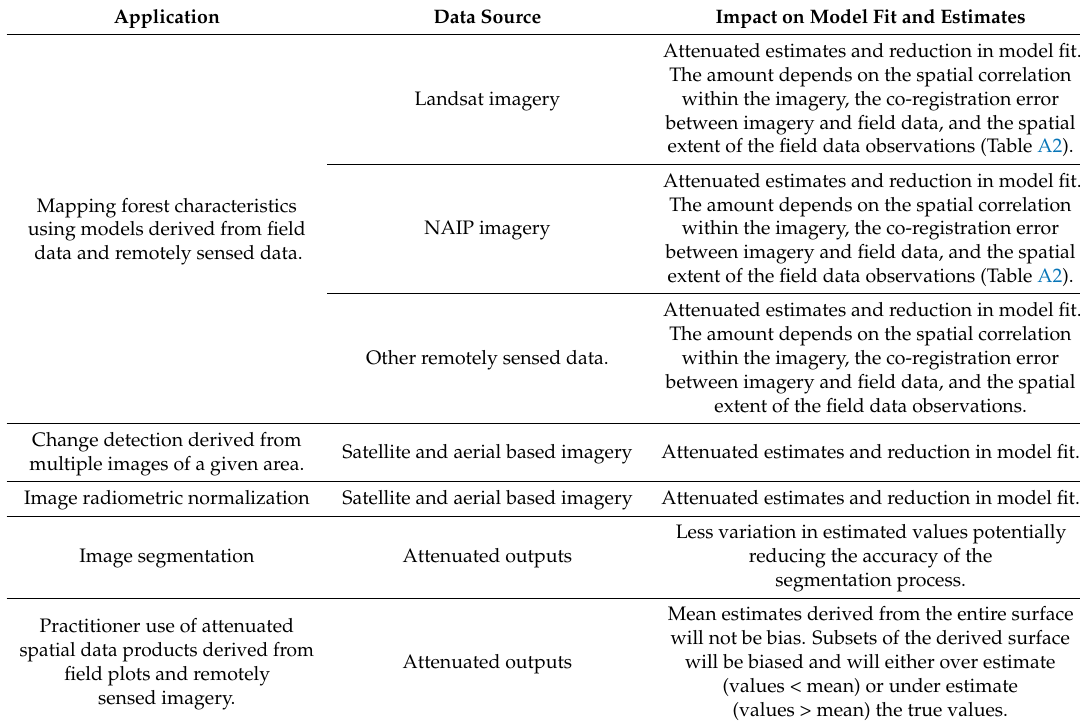
Table A1. Examples of remote sensing applications impacted by co-registration errors and the impact on model fit and estimates.